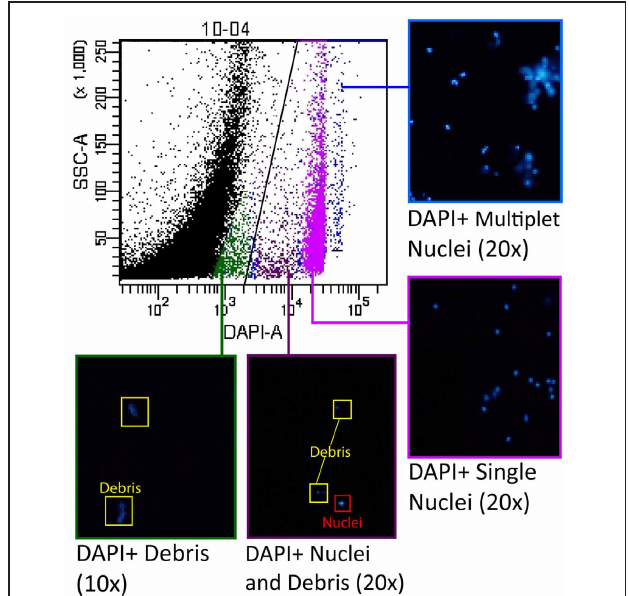
FIGURE 2 | Groups of nuclei were selected from the scatterplot for analysis by cell sorting to ensure optimal nuclei gate placement. Groups of nuclei resulting from the sort were examined under a fluorescence microscope to identify the characteristics of each of the major subpopulations visible on the scatterplot. The area of the scatterplot indicated in blue contained primarily multiplets of nuclei (“doublets”, “triplets”, etc.), while the area indicated in pink contained the DAPI positive “singlet” nuclei that were brightly labeled. The area of the scatterplot indicated in purple contained some debris, but also a population of dimly labeled and irregularly-shaped nuclei. The scatterplot area indicated in green contained only